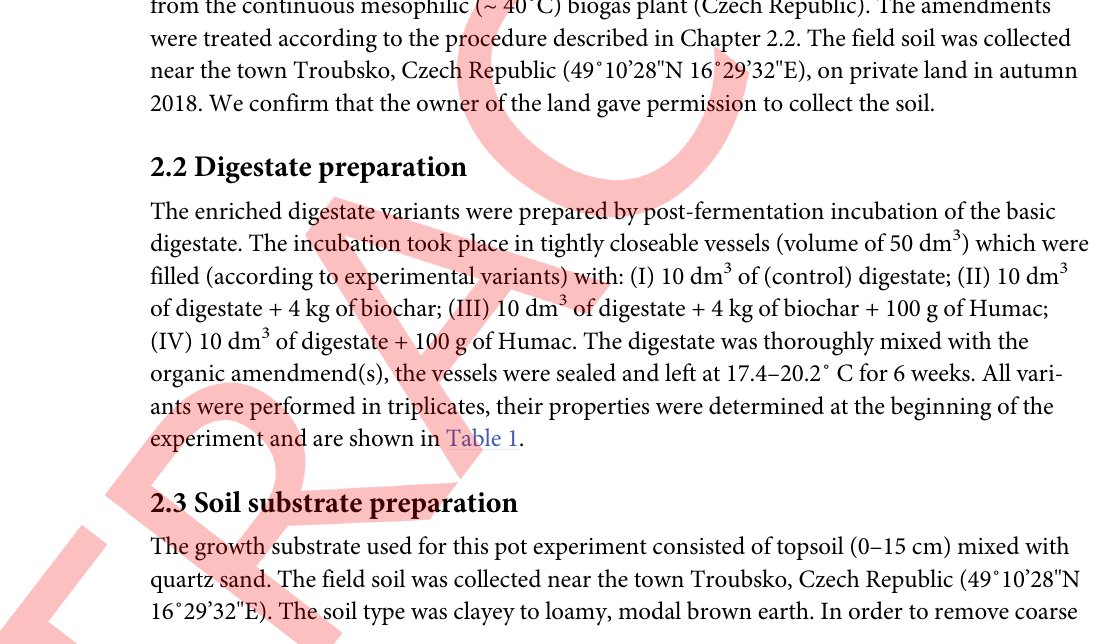
Table 1. Properties of digestates used in the pot experiment.